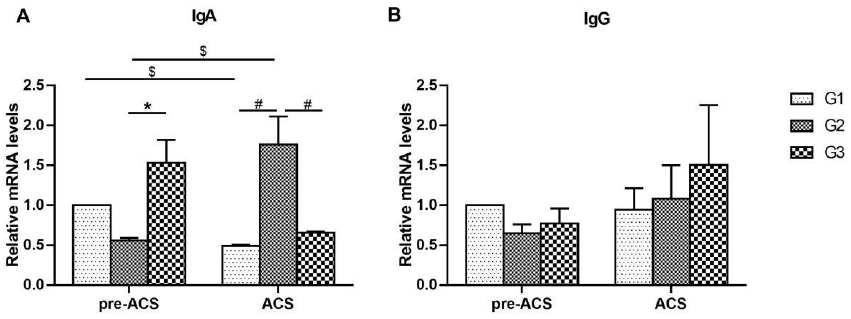
Figure 2 . The mRNA levels of immunoglobulins IgA ( A ), and IgG ( B ) in ilea of broilers before and after ACS. Data were presented as mean ± SD ( n = 6). Different labels represent significant differences ( p < 0.05). pre-ACS (*), ACS (#) and before and after ACS ($). G1, cold stimulation for 0 h; G2, cold stimulation for 3 h; G3, cold stimulation for 6 h.